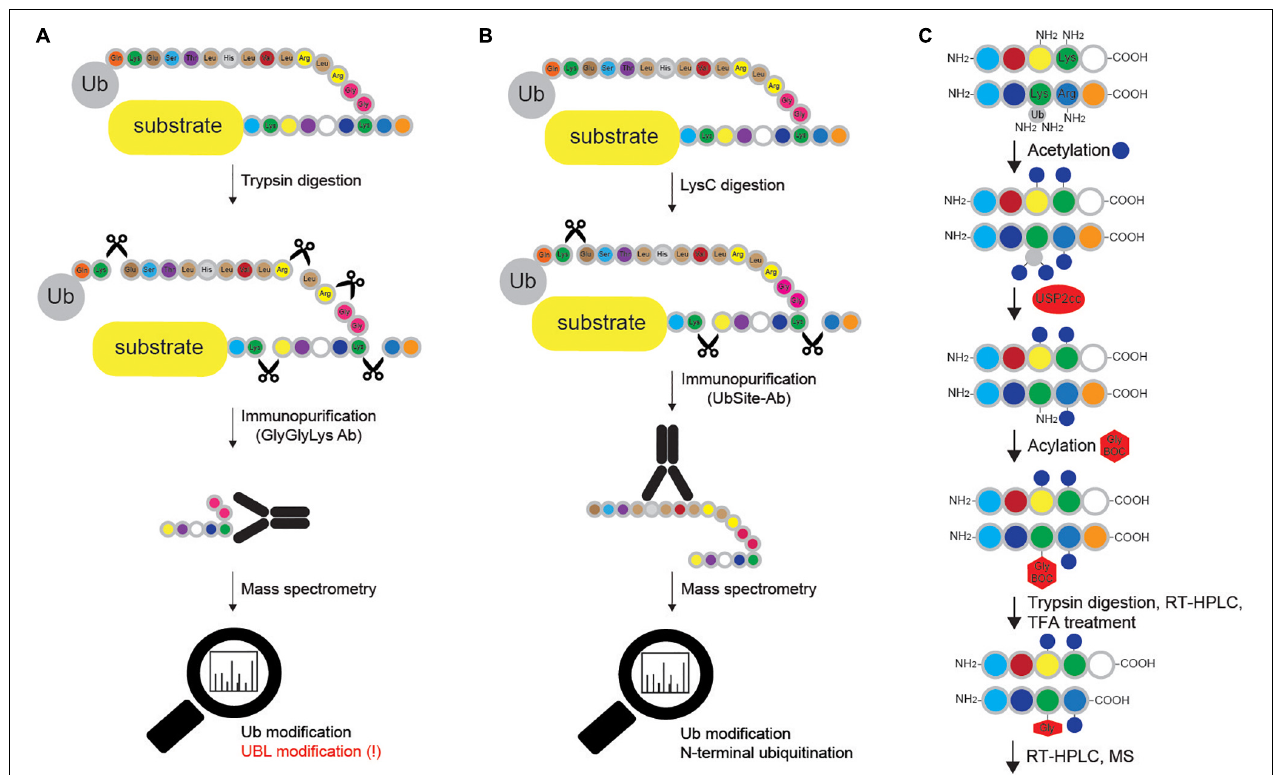
FIGURE 6 | Methods for mapping ubiquitination sites in proteins. (A) Ub remnant profiling is based on trypsin digestion of the proteome (cells are previously lysed in urea-containing buffer) combined with immunoprecipitation with monoclonal antibody raised against Lys- ε -Gly-Gly motif that remains on ubiquitinated substrate after trypsin cleavage. Samples are further processed and analyzed by LC-MS/MS. Such approach does not distinguish between modifications by Ub and other UBLs (such as NEDD8 and ISG15), and cannot be applied for Met1- and N-terminally Ub-modified proteins. (B) UbiSite antibody recognizes the last 13 amino acids of Ub that remain attached to ubiquitinated proteins upon LysC cleavage. Enriched ubiquitinated proteins are further analyzed by MS. Even though UbiSite approach distinguishes between modifications by Ub and other UBLs, it cannot be used for studying linear ubiquitination, as it does not recognize the signature peptide of linear ubiquitination after tryptic cleavage: Gly-Gly-Met-Gln-Ile-Phe-Val-Lys. (C) Ub-COFRADIC approach distinguishes between free ( α or ε ) and modified primary amines to enable identification of ubiquitinated Lys residues. Initial acetylation by NHS-acetate is only possible on free amines, leaving ubiquitinated Lys residues non-acetylated. Subsequent addition of USP2cc removes all the Ub moieties from Lys residues and enables the attachment of Gly linked to a hydrophobic tert-butyloxycarbonyl (Gly-BOC tag) to previously non-acetylated Lys residues. Trypsin then cleaves C-terminally of Arg residues (but not C-terminally of